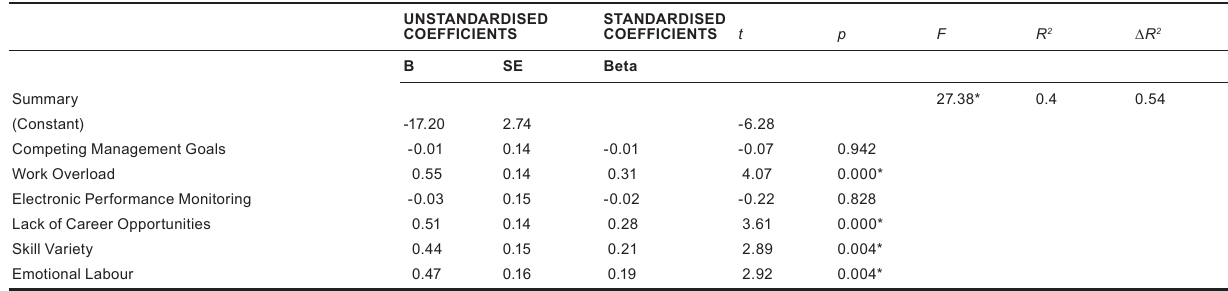
table 3 Multiple regression analysis with Burnout as dependent